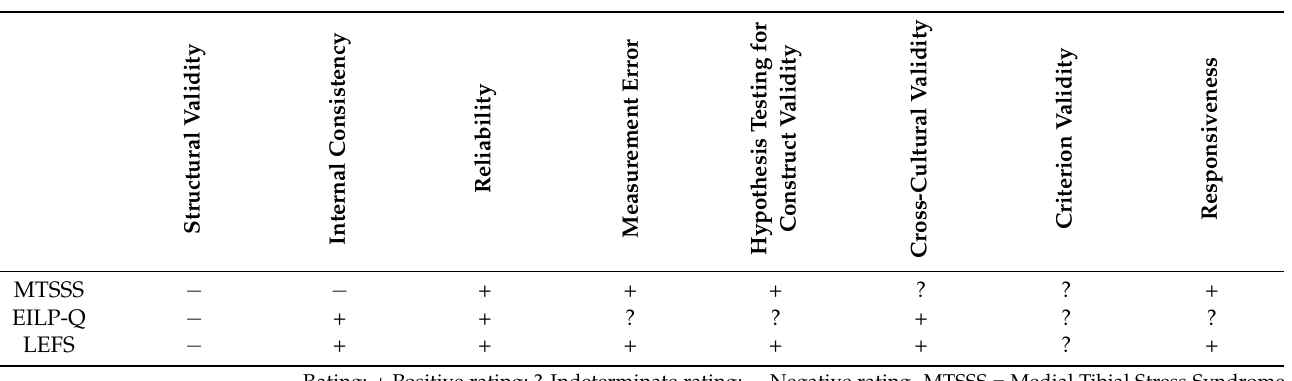
Table 3. Detailed COSMIN ratings